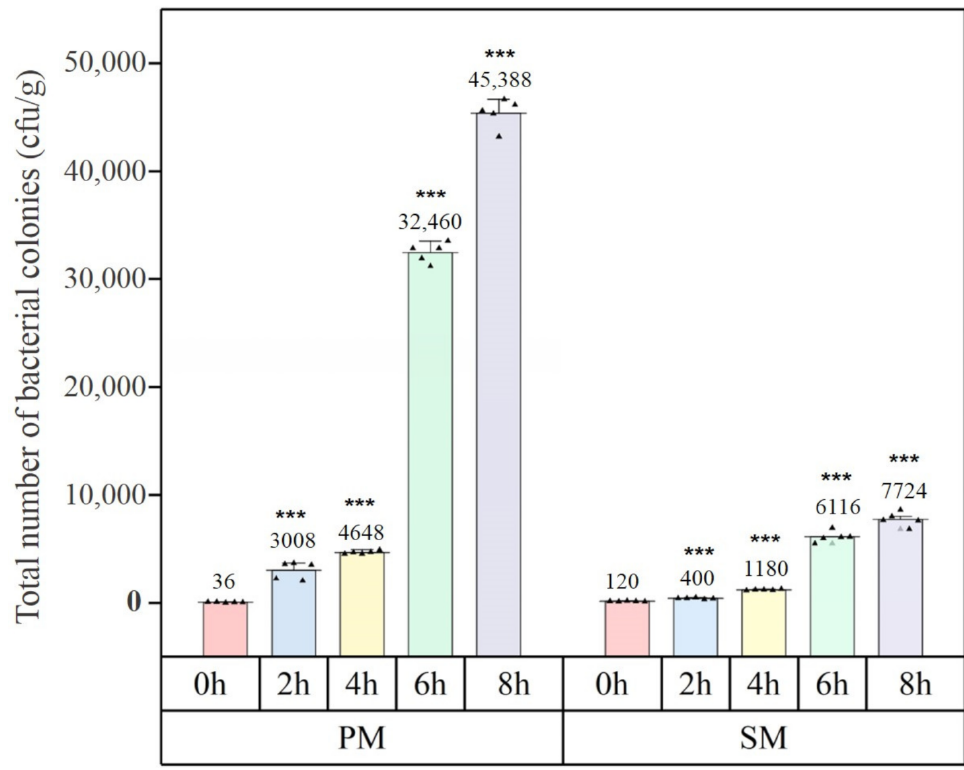
Figure 7. Results of colony formation after mask use. (cid:78) represents a data point. ***: p value <